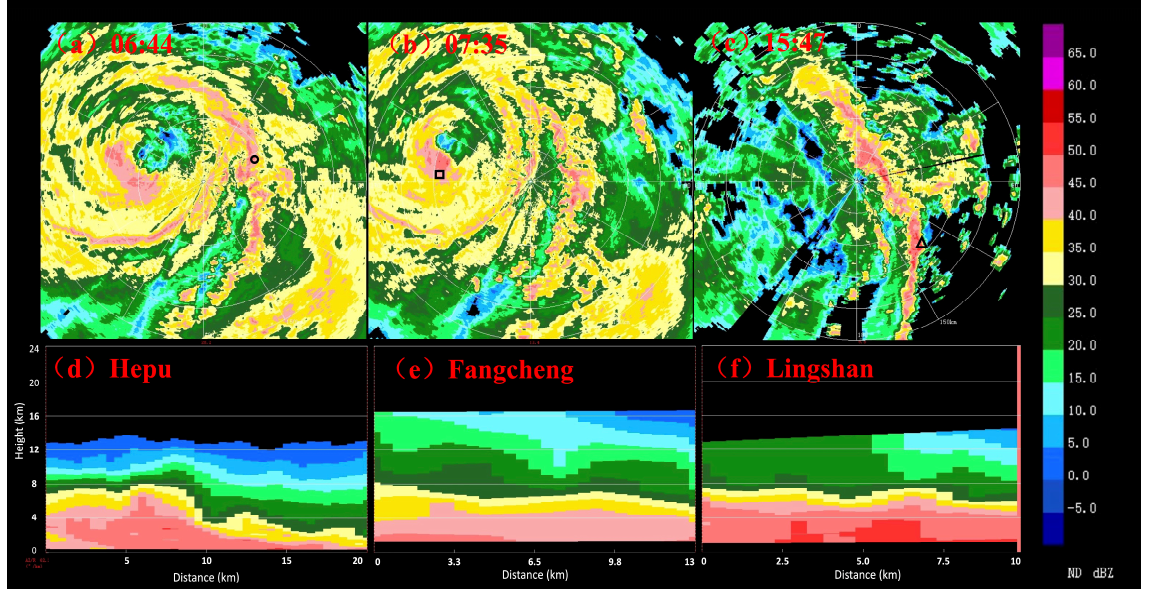
Figure 6 . The horizontal distributions (at 1.5° elevation) and cross sections of radar reflectivity (dBZ) from Doppler weather radar at the peak of three rainstorms centered at ( a , d ) Hepu, ( b , e ) Fangcheng, and ( c , f ) Lingshan.